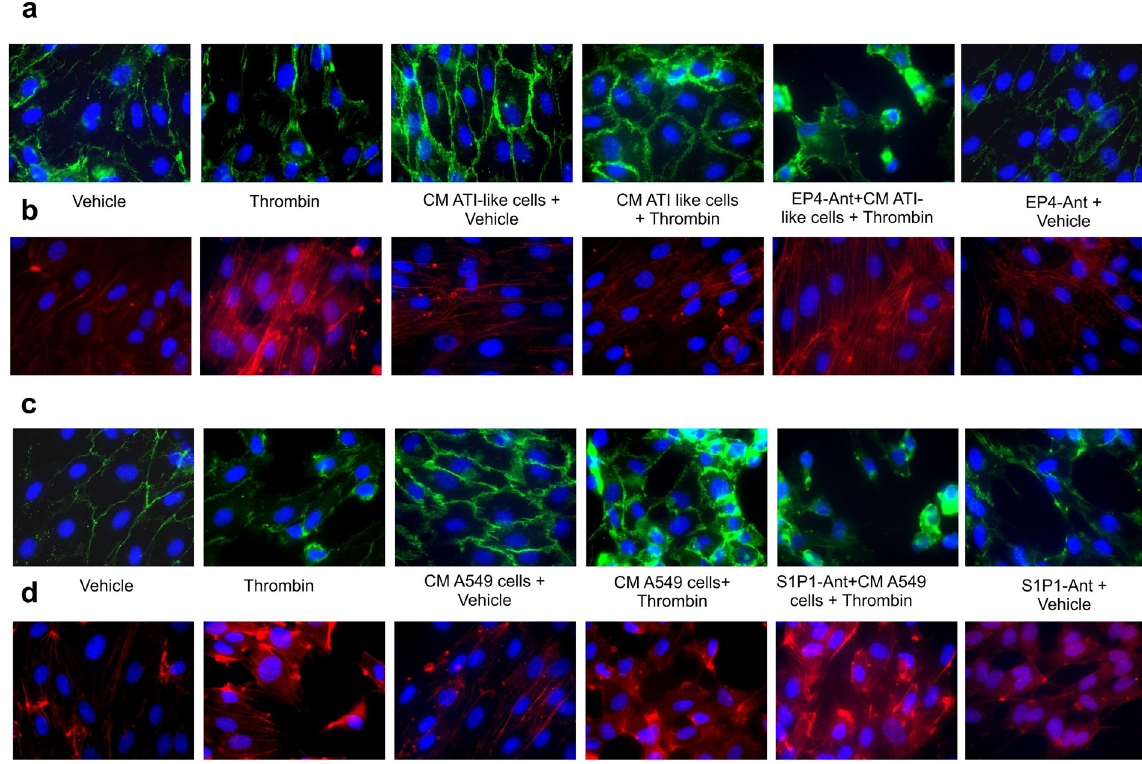
Figure 7. Conditioned medium protects endothelial cells from thrombin-induced disruption of adherens junctions and stress fiber formation. HMVEC-L were grown in chamber slides and pretreated with either vehicle, the EP4 antagonist ONO AE3 208 (EP4-Ant; 300 nM) or the S1P 1 antagonist W146 (S1P1-ANT; 10 µ M) as indicated. Conditioned medium (CM) from ( a , b ) ATI-like cells or ( c , d ) A549 cells was added followed by 0.5 U/ml of thrombin or vehicle for 15 min. Afterwards, cells were stained with ( a , c ) an antibody against VE- cadherin (green) to visualize adherens junctions and ( b , d ) phalloidin (red) for stress fiber formation. Nuclei were counterstained using DAPI. Images are representative for 5 different